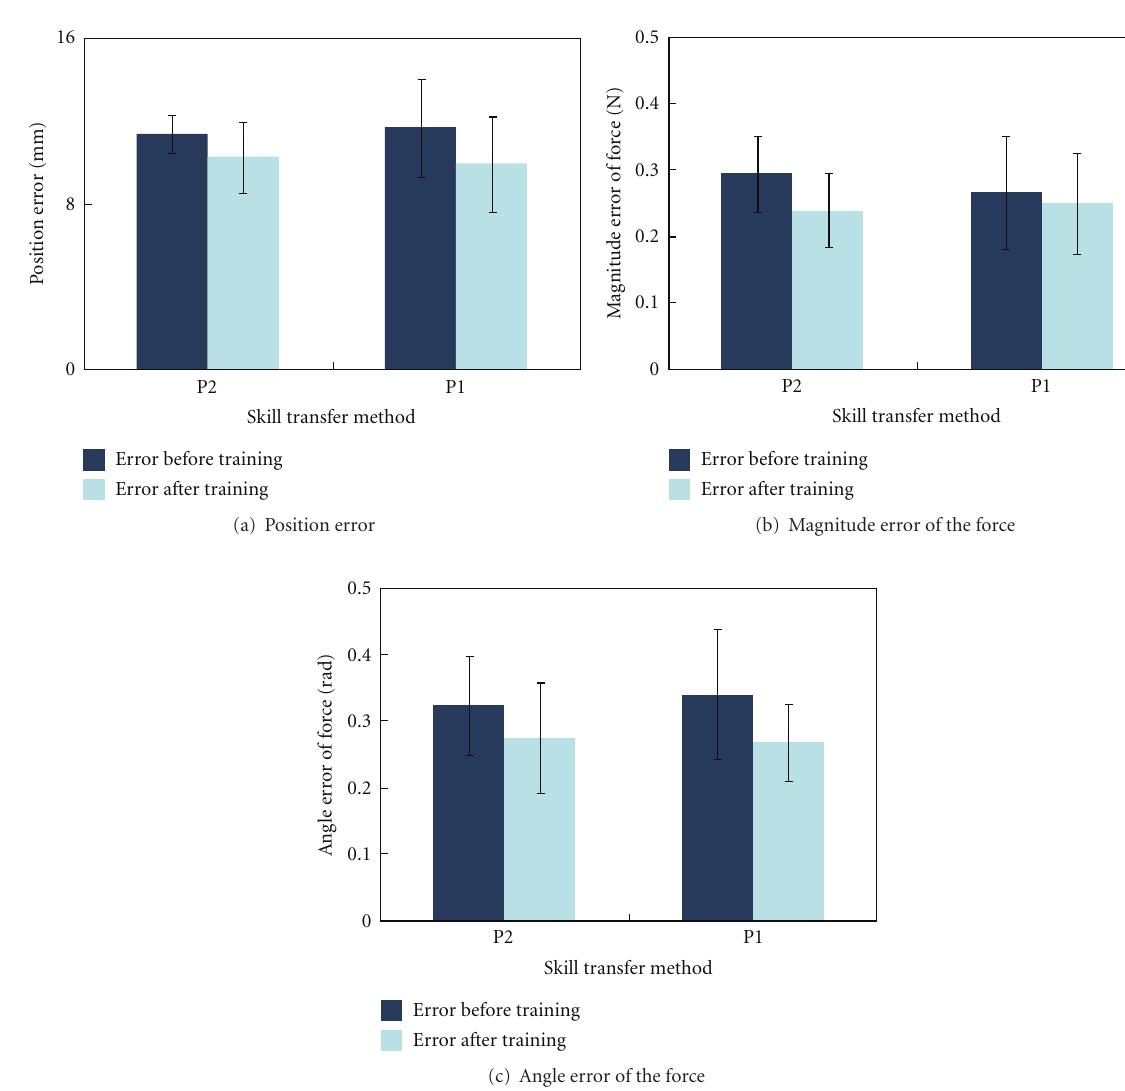
Figure 17: Experimental